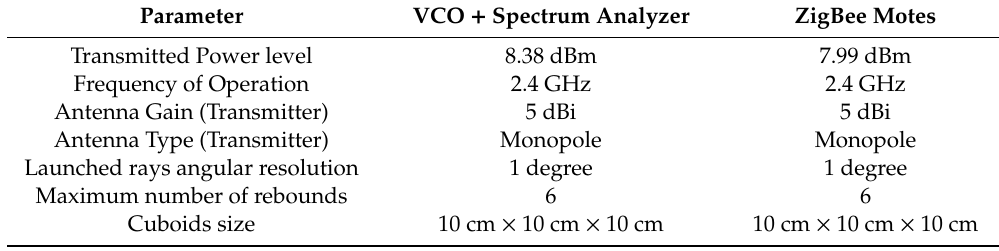
Table 3. Parameters utilized for the 3D ray launching simulations.